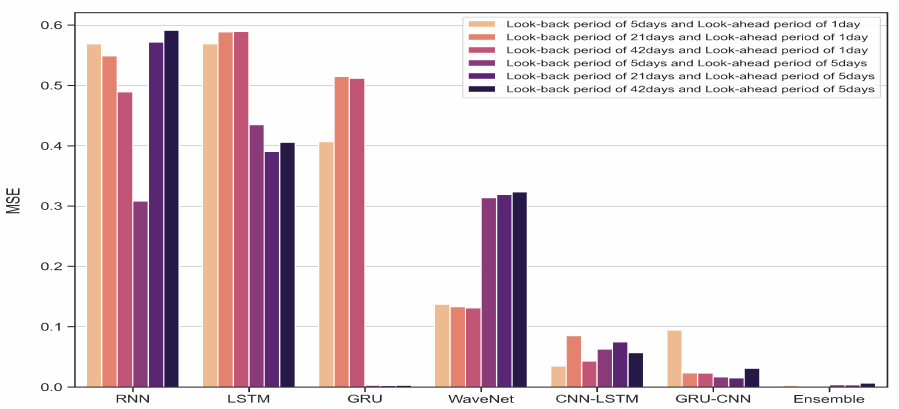
Figure 15. Comparison of the average MSE over three periods for different look-back and look- ahead periods using RNN, LSTM, GRU, WaveNet, CNN-LSTM, GRU-CNN, and ensemble with OHLV